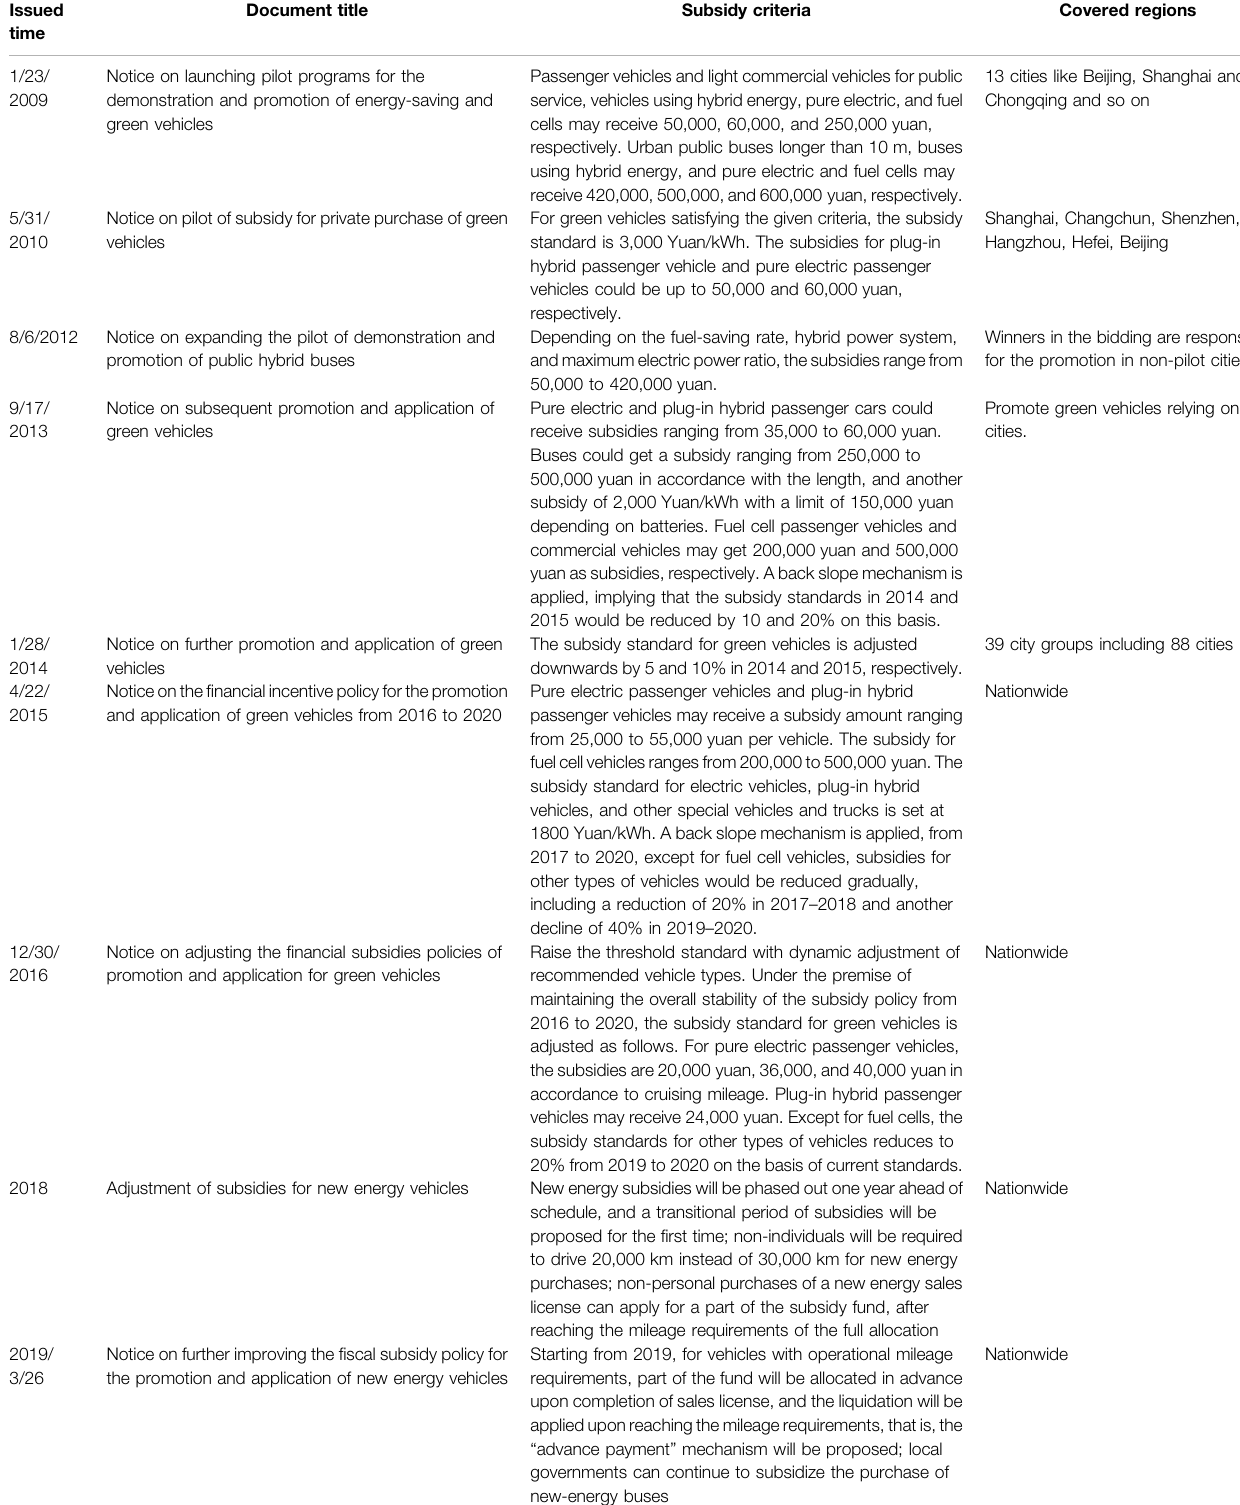
TABLE 1 | A summary of subsidy policies for green vehicles in